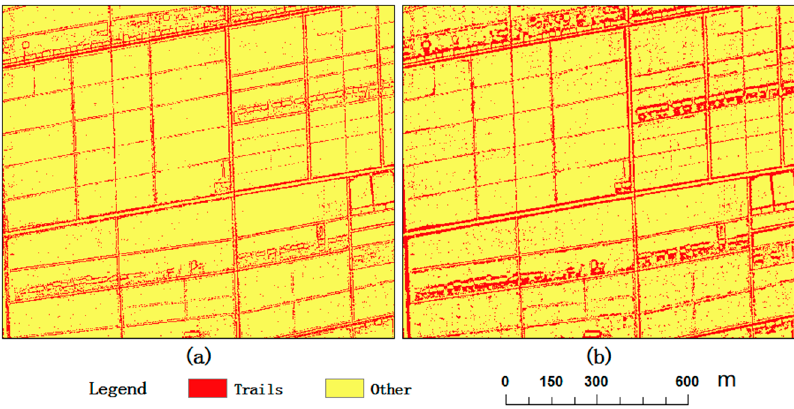
Figure 10. Impact of neighborhood size of the research area: ( a ) 3 × 3 m neighborhood, and ( b ) 12 × 12 m neighborhood.